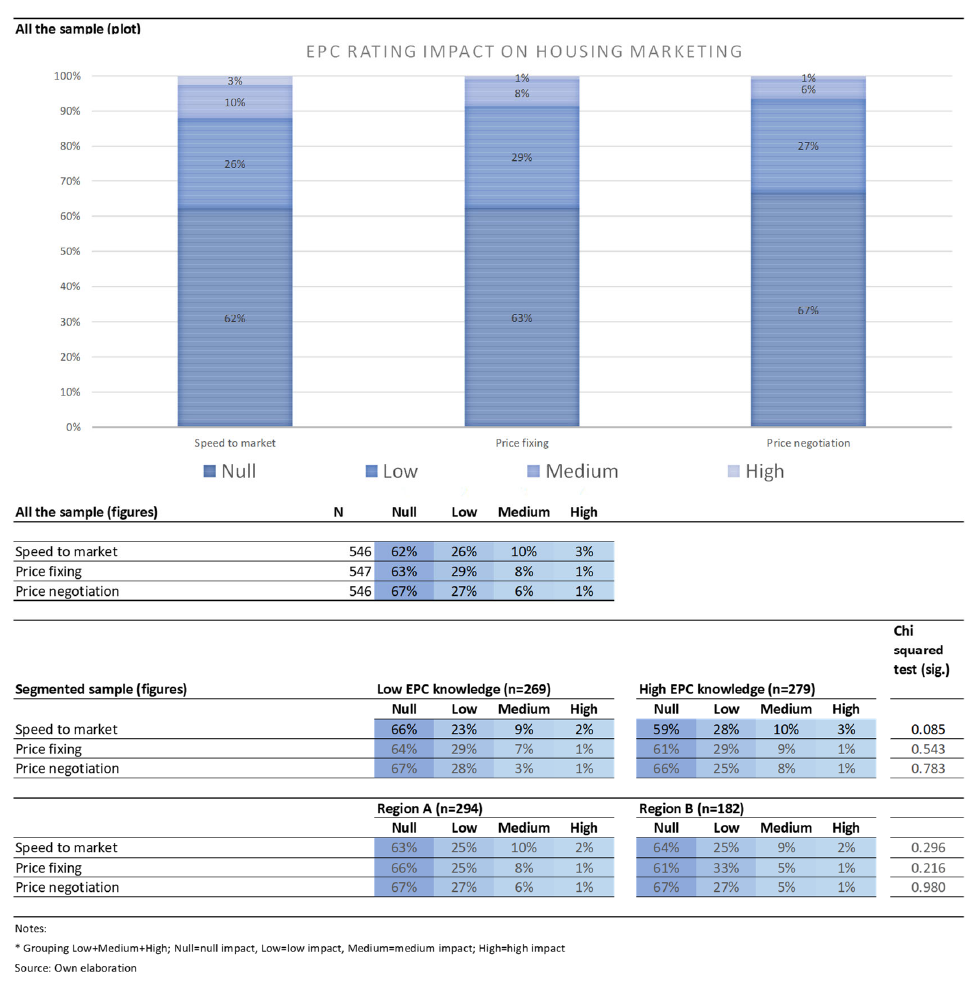
Figure 2. Impact of EPC ratings on the housing market.